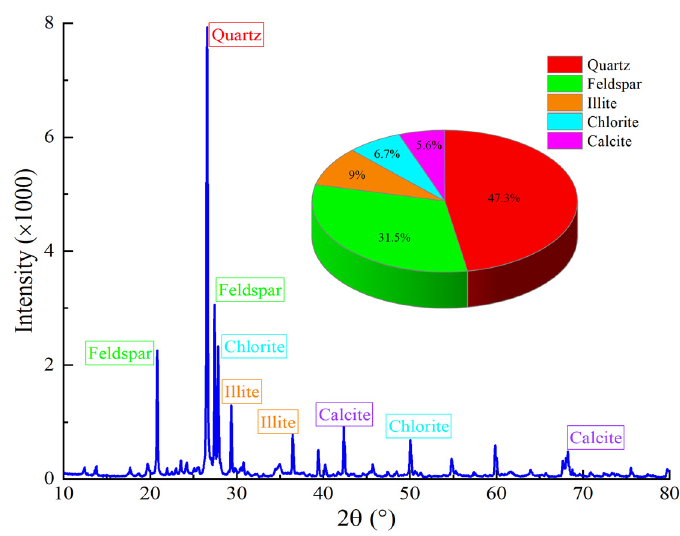
Figure 2. XRD result for the tested